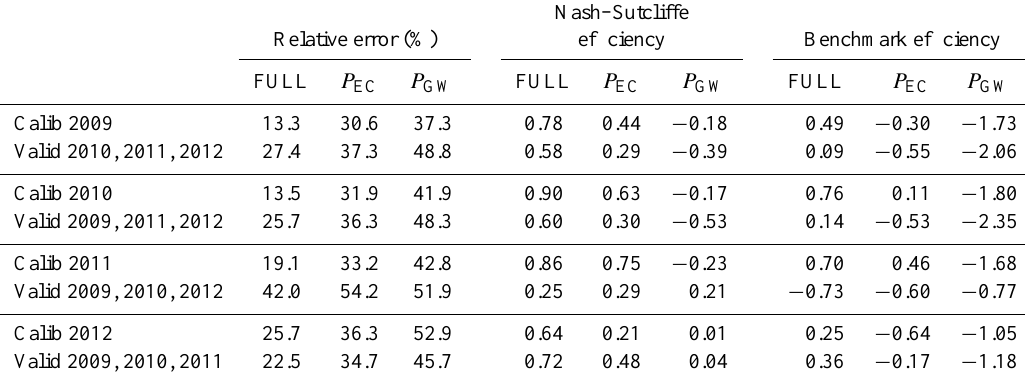
Table 3. Calibration of the full model (FULL) and both partial models ( P EC and P GW ) for four years of data. P EC uses only electrical conductivity data, whereas P GW uses only groundwater level data. For each calibration year, validation is performed on all remaining years.